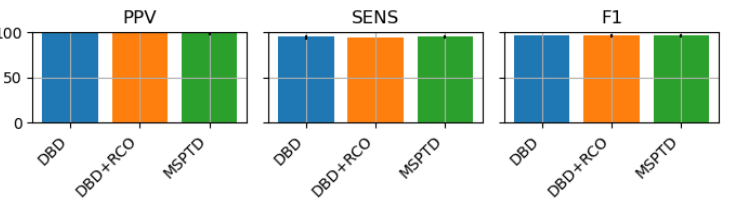
Figure 6. Performances of the heartbeat detection algorithms on the FANTASIA